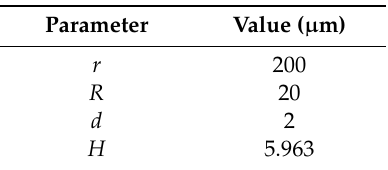
Figure 3. ( a ) Manufacturing equipment and ( b ) a sample fabricated.